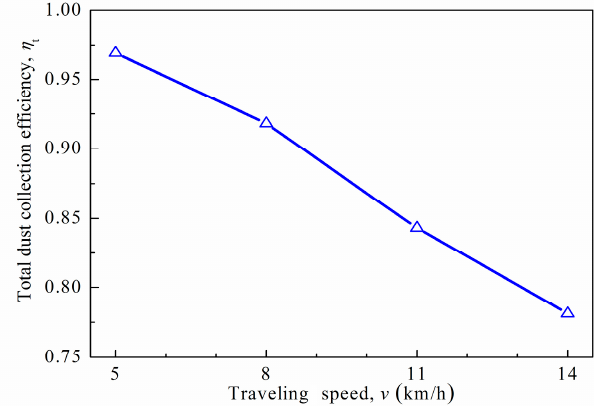
Figure 12. Influence of traveling speed on the separation efficiency. Processes 2020 , 8 , x FOR PEER REVIEW